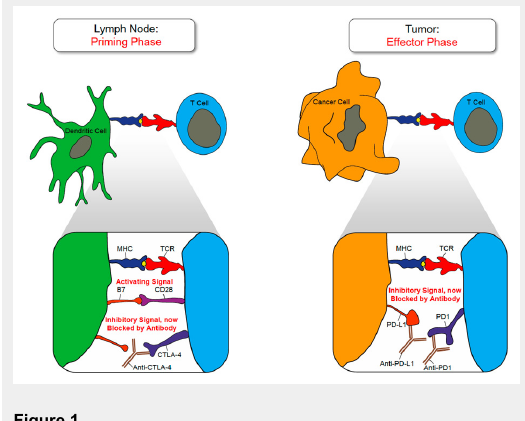
Blockade of CTLA-4 or PD-1 signalling in anti-cancer immunotherapy: The T cell priming phase is schematically depicted on the left site. T cells engage APCs, such as dendritic cells (DCs) via their t-cell receptor (TCR). Recognition of the cognate MHC/peptide complex by the TCR results in the intracellular transmission of an activating signal in the T cell, which is complemented by a co-activating signal provided by the CD28/B7 interaction. In order to down-modulate T cell priming and expansion CTLA-4 is up regulated on activated T cells after 2–3 days and competes with CD28 for B7. CTLA-4 blocking antibodies can therapeutically inhibit the co-inhibitory signal provided by CTLA-4. On the right site the effector phase is outlined. During this phase immune effector function can be dampened by PD-1/PD-L1 interaction. PD-1 or PD-L1 blocking antibodies can therapeutically inhibit the co-inhibitory signal provided by the PD-1/PD-L1 interaction and restore effector function in tumour resident effector T